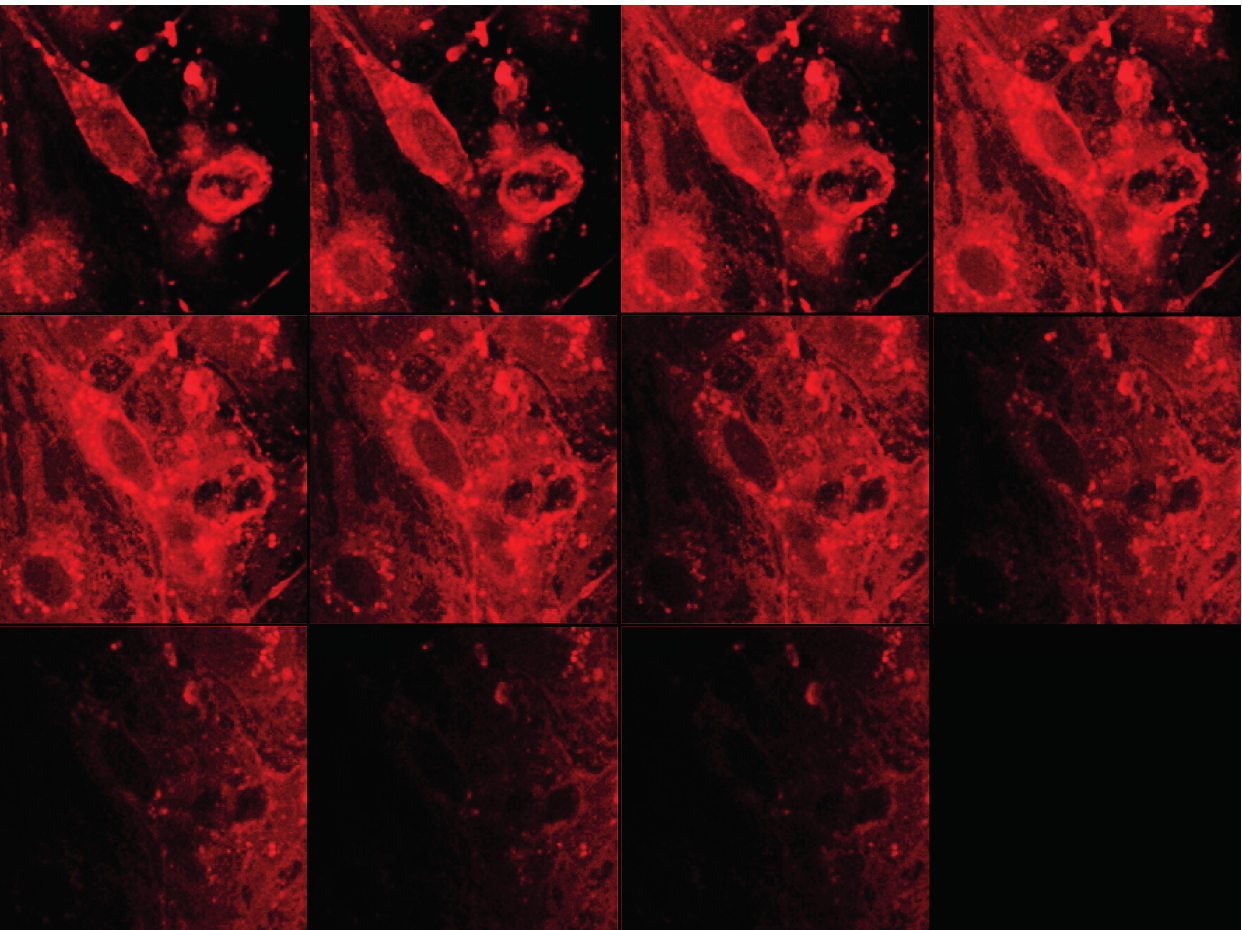
Figure 4. Fluorescence images of live porcine brain capillary endothelial cells (PBCEC) in z-stack incubated with cBSA-liposomes at 100 µM. Steps between images were 20